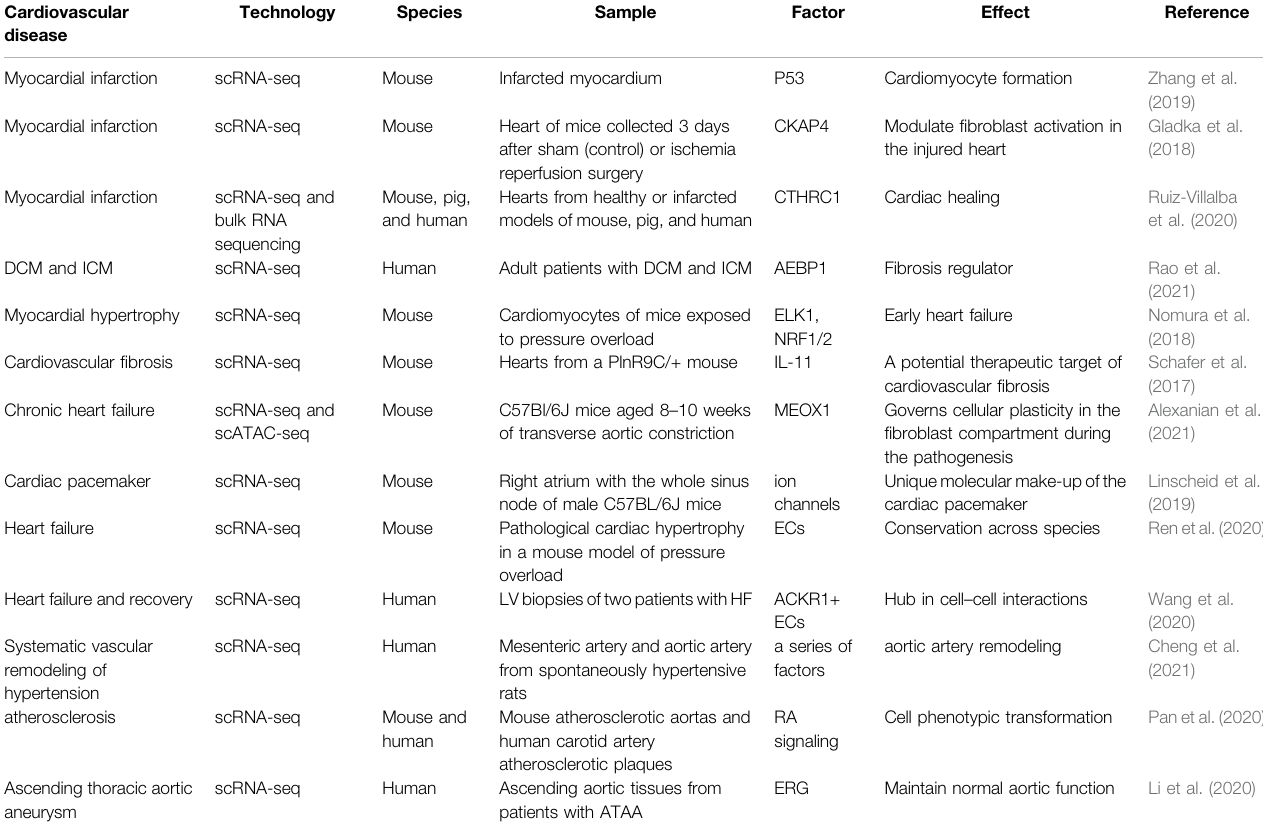
TABLE 2 | scRNA-seq and cardiovascular